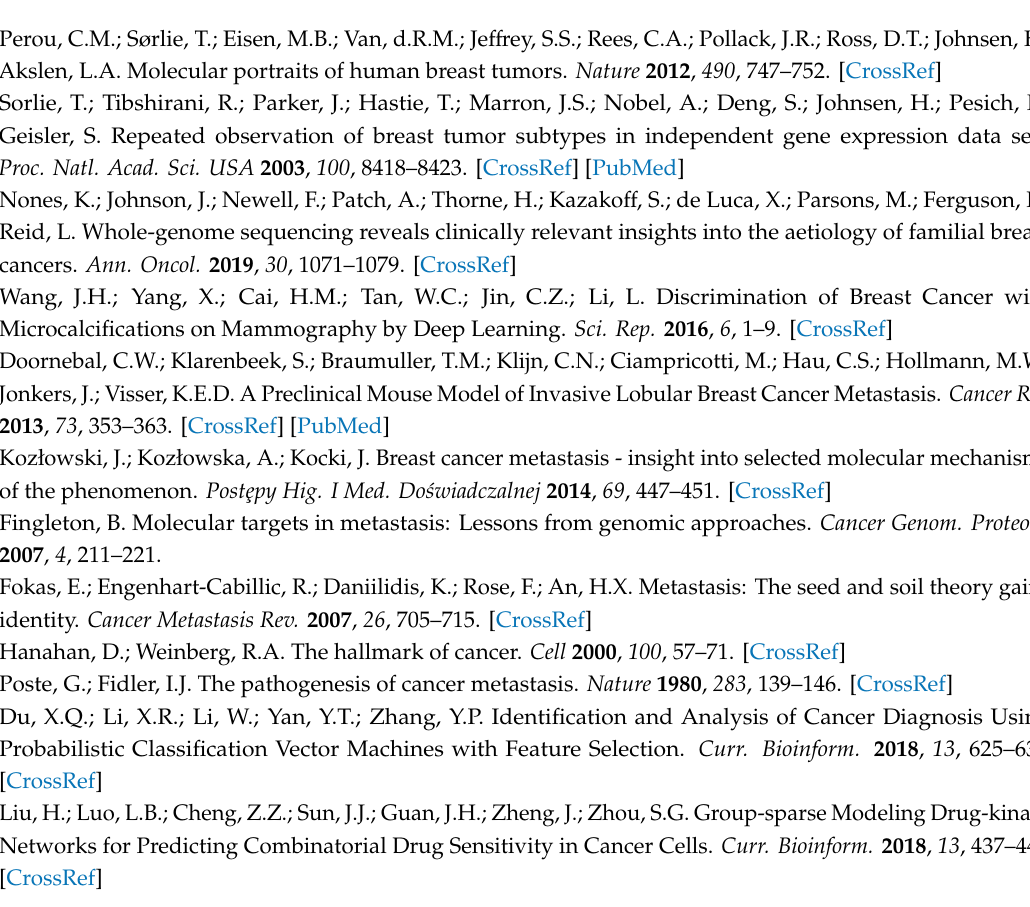
Table S1: The detailed information on all CpGs; Table S2: The detailed prediction performance; Table S3: 134 di ff erentially methylated sites detected from MRMD; Table S4: 98 genes related to the 134 CpG markers; Table S5: Five breast cancer biomarkers CpGs predicted by our